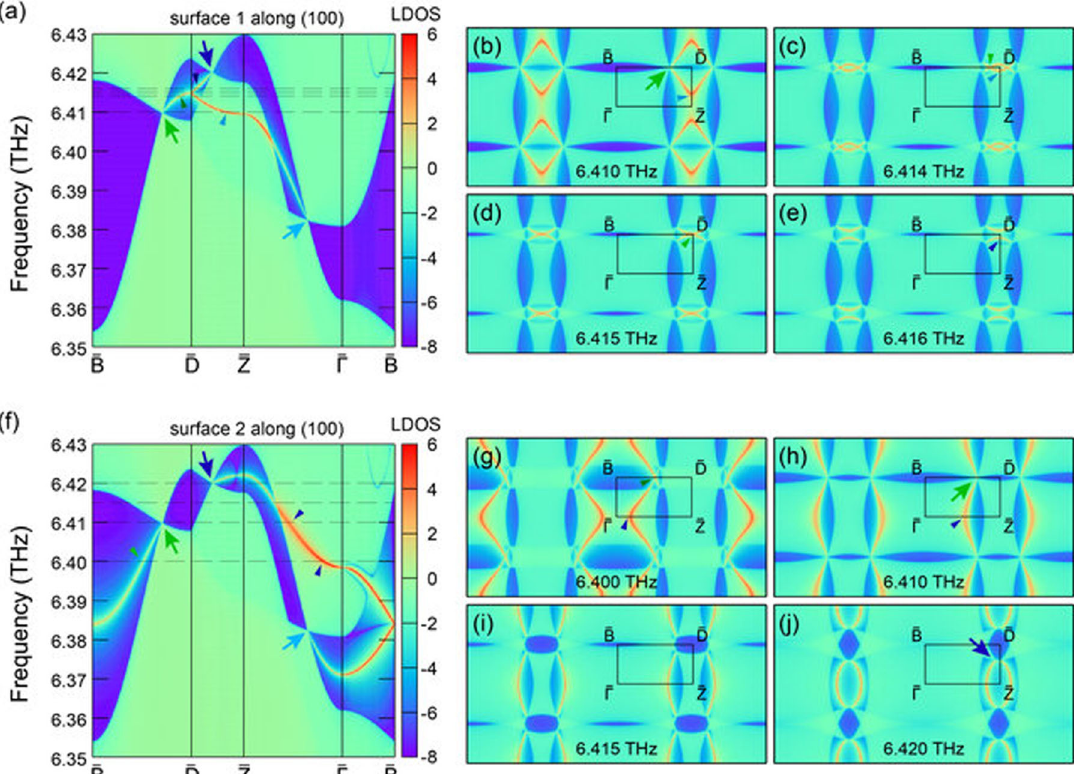
Fig. 4 Topological surface states of SnIP. a Topological surface states of surface 1 along the (100) direction, as well as the surface arcs for phonon frequencies of b 6.410 THz, c 6.414 THz, d 6.415 THz and e 6.416 THz. f Topological surface states of surface 2 along the (100) direction, as well as the surface arcs for phonon frequencies of g 6.400 THz, h 6.410 THz, i 6.415 THz and j 6.420